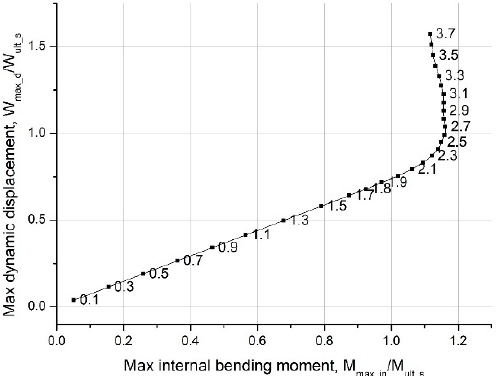
Figure 18. Internal bending moment and vertical displacement for mid-span box girder M5 at load duration time T d = 0.005 s (Data label denotes M d /M ult_s ).